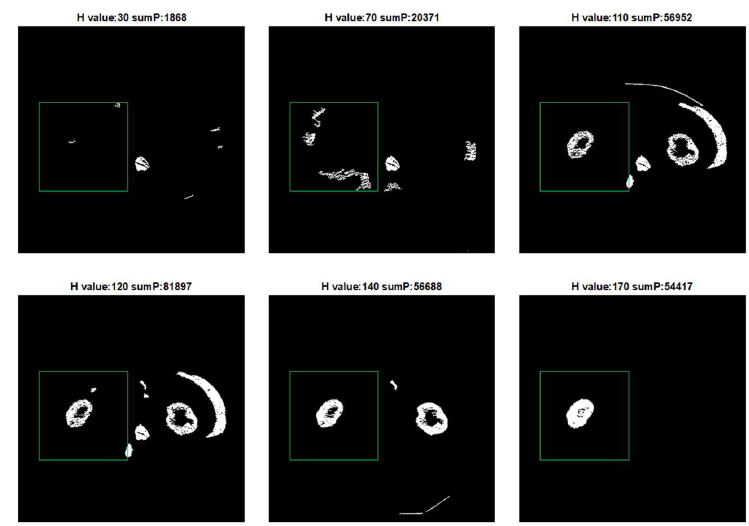
Figure 2. The result of the extended-maxima transform operation for the selected parameters H = [30, 70, 110, 120, 140, 170]. The green frame shows an exemplary starting area 𝑆𝑚 .